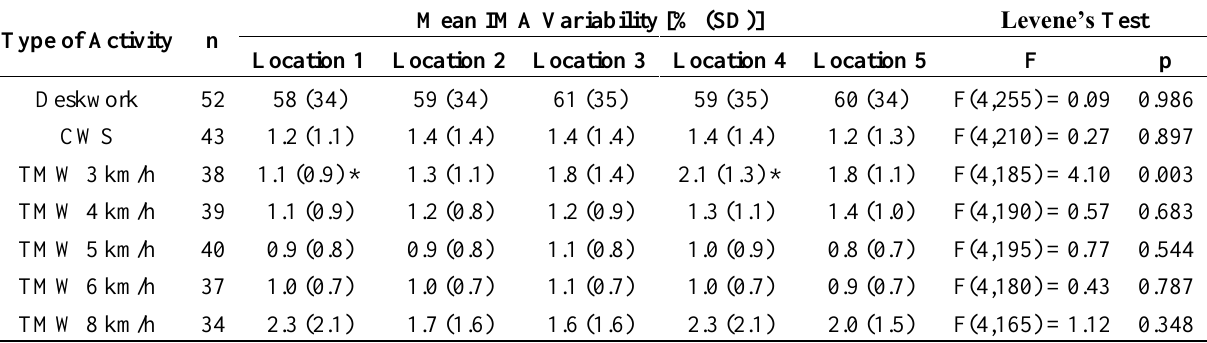
Table 3. Minute-to-minute variability in IMA values during activities in absolute percentual deviation from the mean IMA for a specific activity, at a specific sensor location and for each subject. n = number of IMA samples. CWS = Comfortable walking speed. SD = Standard